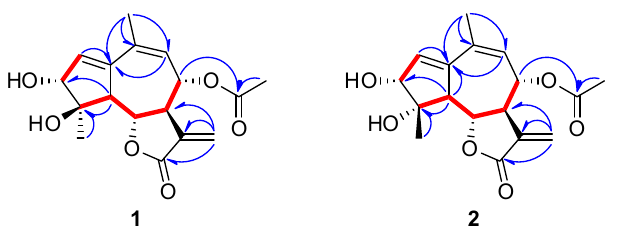
Figure 2. Key correlations observed in the COSY ( ▬ ) and HMBC ( ) NMR spectra of 1 and 2 .